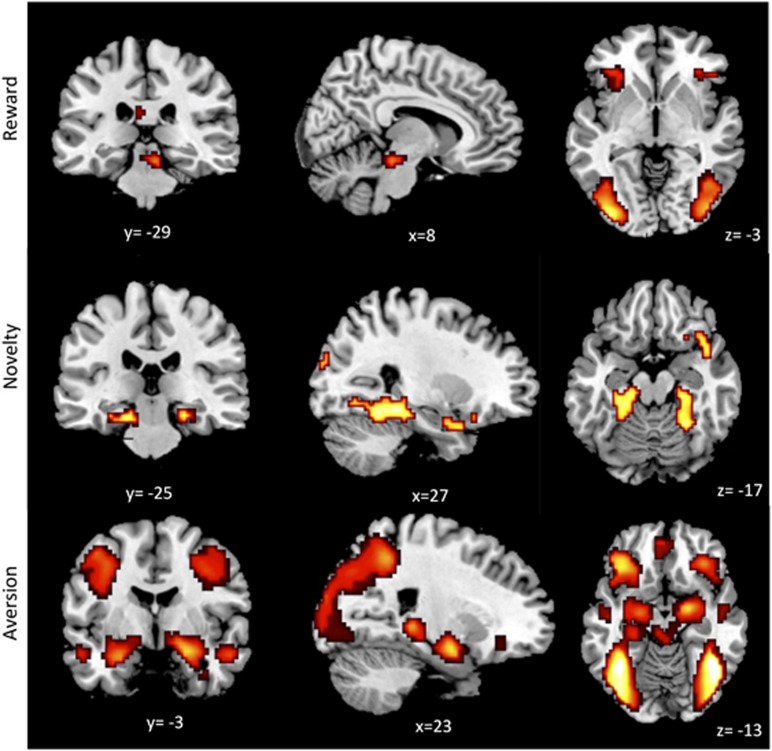
Salience Intigration Task effects in healthy control subjects. Reward predicting stimuli-related activation was seen in the midbrain, bilateral orbitofrontal cortices and visual areas. Novel stimuli-related activation was seen in the hippocampus and secondary visual cortices bilaterally. Aversive stimuli-related activation was seen in the amygdala, hippocampus and midbrain bilaterally, visual and fusiform cortices, and orbital, ventromedial and dorsolateral prefrontal cortices.